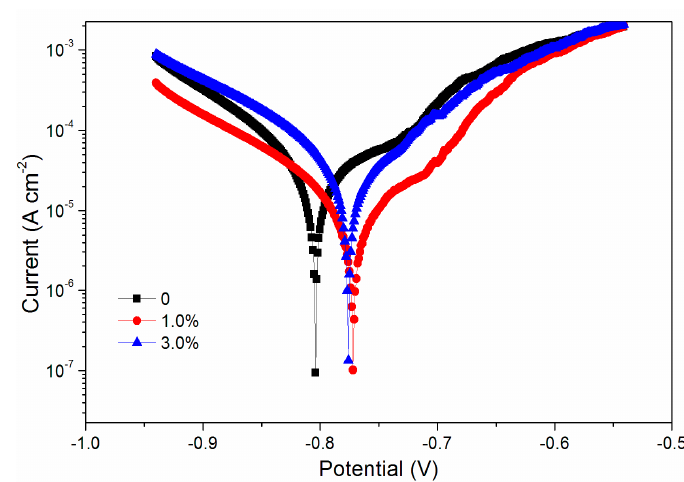
Table 3. Effect of black paste content on corrosion resistance.